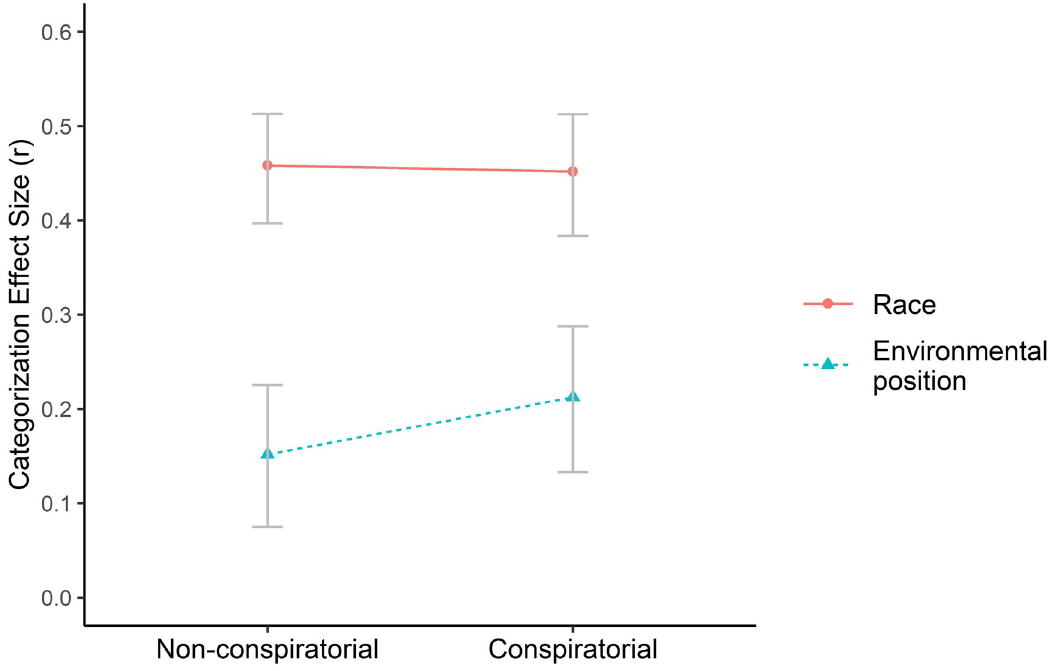
Fig 3. Categorization by race and environmental position when statements are either framed in a non-conspiratorial form (control) or in a conspiratorial form aligned with environmental position (treatment) (N = 1195). Both race environmental position categorization scores do not significantly differ across conditions. The reported numbers are effect sizes (r). Error bars correspond to bootstrapped 95% confidence